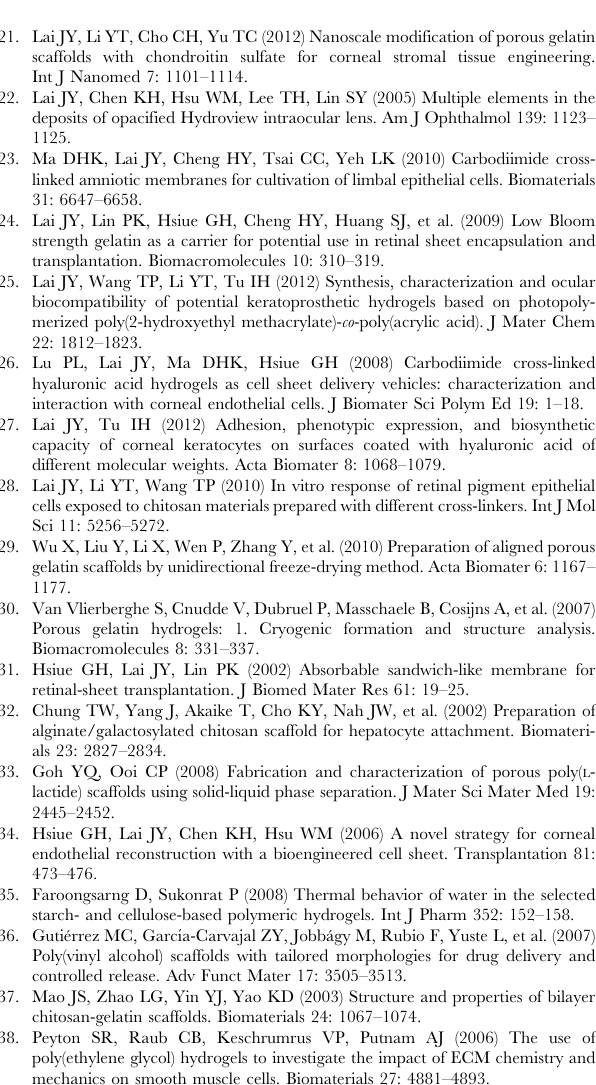
Figure S1 Gross observations. Typical photographs of gelatin sample G15 are shown (a) before testing and (b) after incubation in BSS at 34 u C for 1 h. (TIF) Video S1 Surgery. Implantation of a cross-linked porous gelatin disc in the anterior